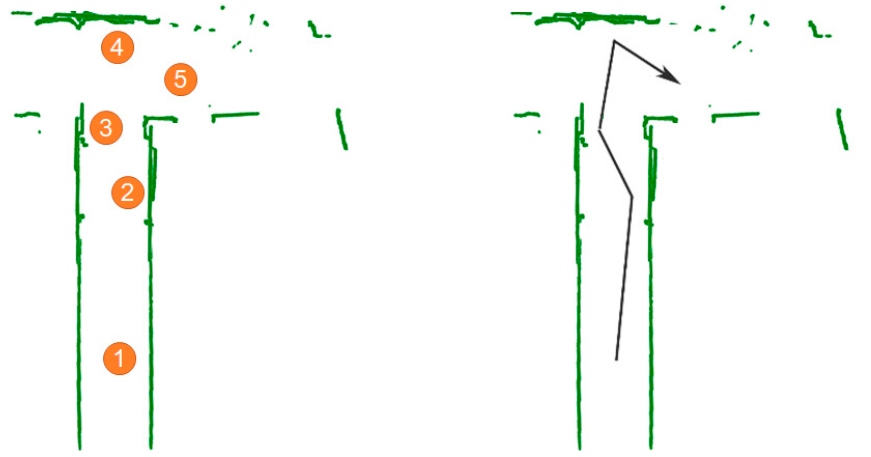
Figure 29. Integrated image of scanned result in third autonomous scanning experiment. The numbers indicating the positions after movement form the starting position of the autonomous scanner ( left ); also, the trajectory of the autonomous scanner is indicated ( right ).